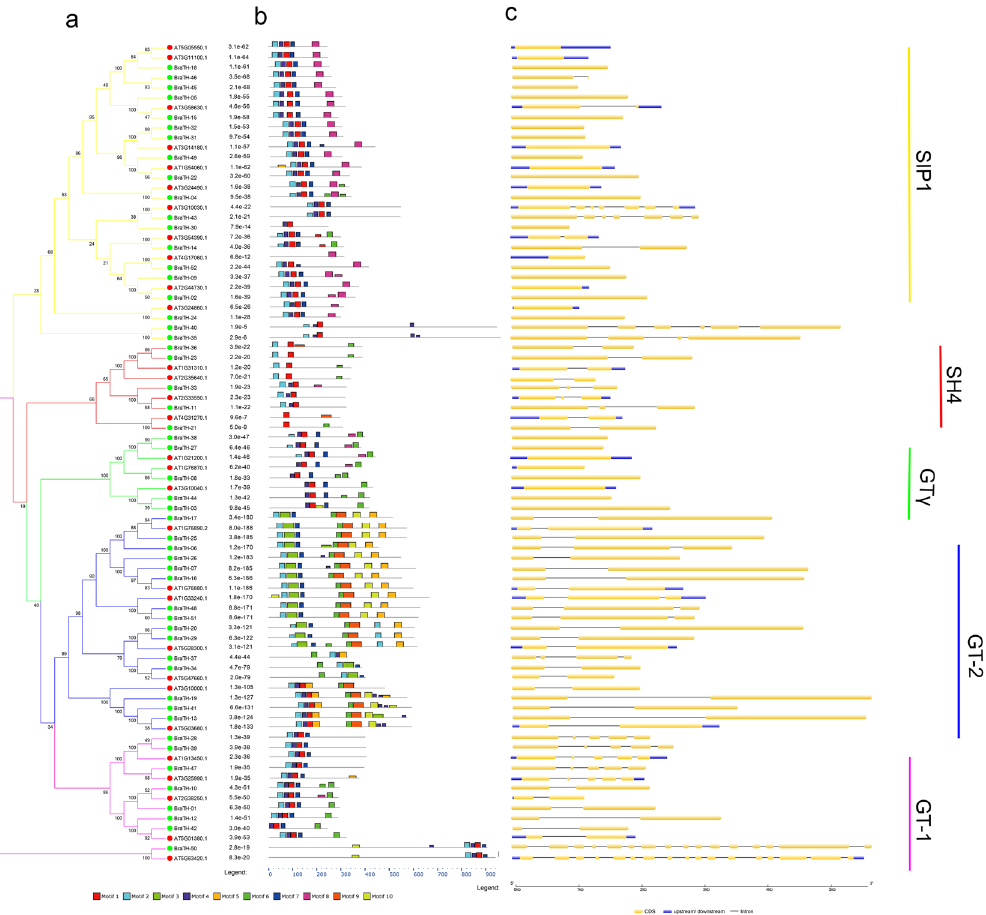
Figure 3. Schematic diagram of amino acid motifs and gene structures of trihelix genes in Arabidopsis and B. rapa